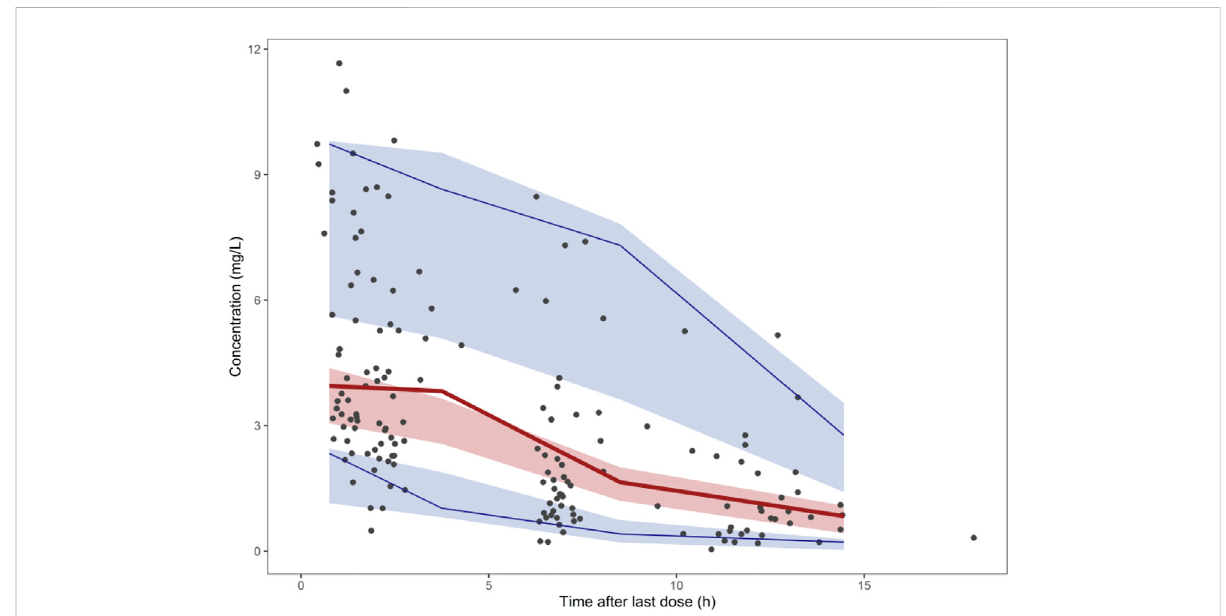
FIGURE 3 Prediction-andvariability-correctedvisualpredictivecheck(pvcVPC)plotofthe fi nalmodel.Theredsolidlinesrepresentthemedianobserved concentration, and the semitransparent red fi elds represent the simulation-based 95% con fi dence intervals (CIs) for the median. The observed 5th and 95th percentiles are represented by red dashed lines, and the 95% CIs for the corresponding model predicted percentiles are shown as semitransparent blue fi elds. The observed concentrations are represented by dark